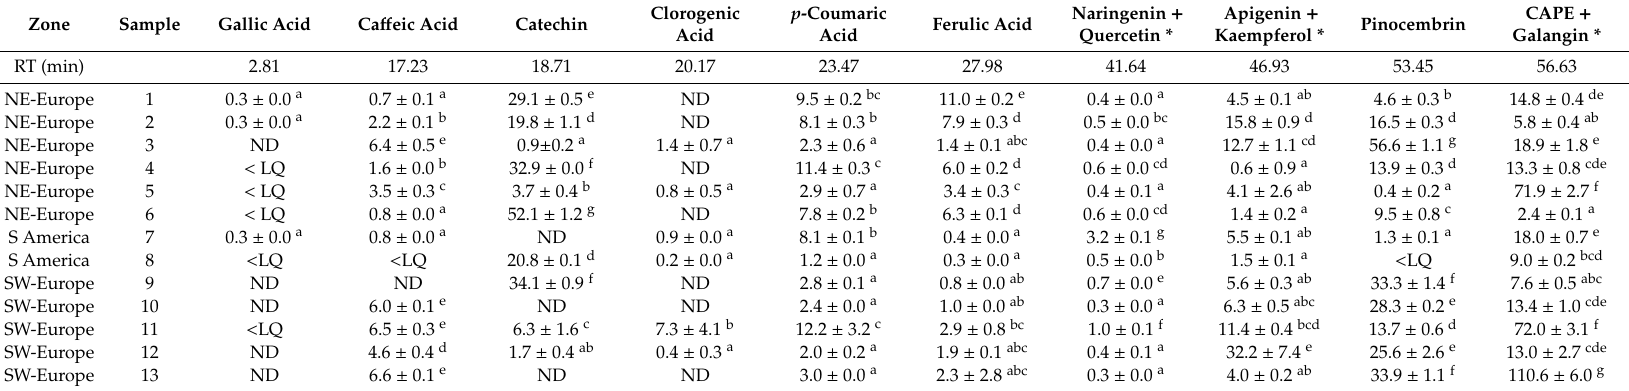
Table 1. Phenolic compounds (mg / g propolis) quantified by HPLC-UV in propolis from di ff erent geographical